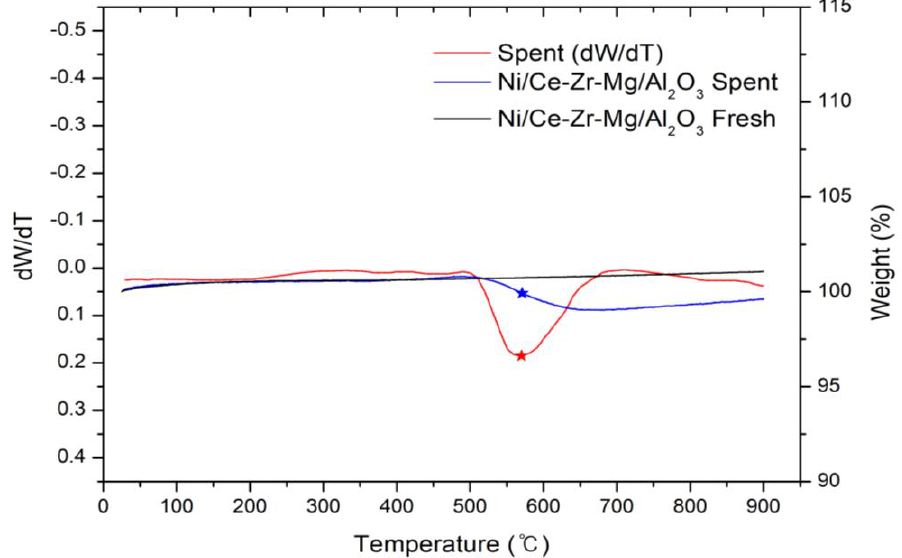
Figure 6. TGA analysis under atmosphere for the 3 wt.% Ni/Ce-Mg-Zr/Al 2 O 3 catalyst.